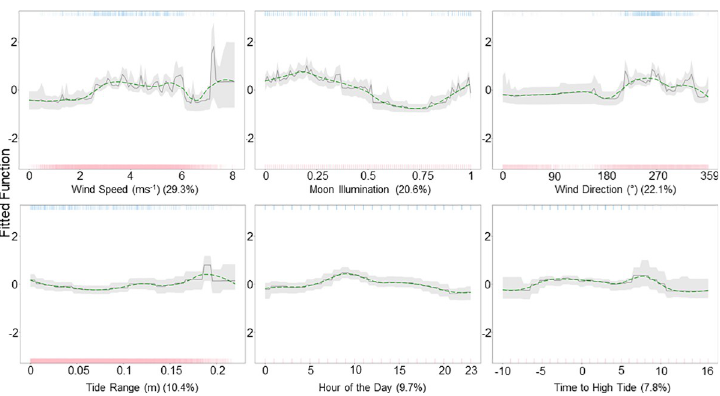
Fig 6. Partial dependency plots for Dhigu Thila. The effect of each predictor variable on the occurrence of tagged M . alfredi at Dhigu Thila while keeping all other variables at their mean. The green line shows locally weighted smoothing (LOESS). Rugs display the distribution of the data for presence (top, blue), and absence (red, bottom).